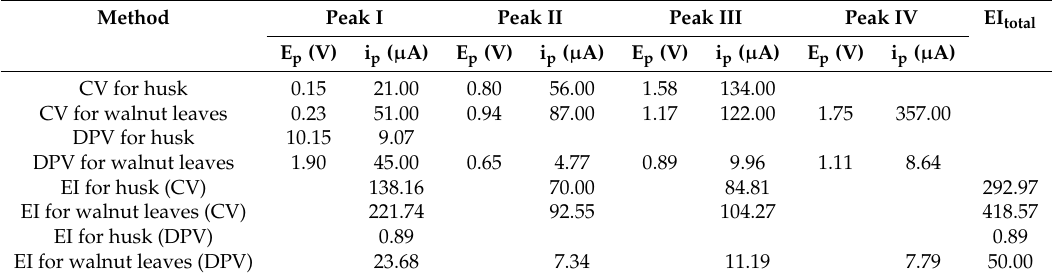
Table 3. Peak potentials (E p ) and currents (I p ) determined from CV i DPV, antioxidant capacity